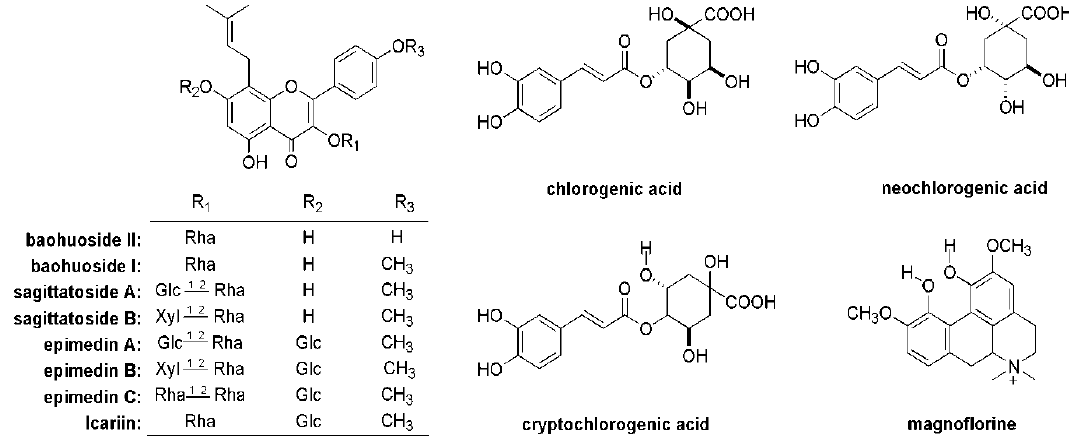
Figure 3. The chemical structures of the 12 compounds.